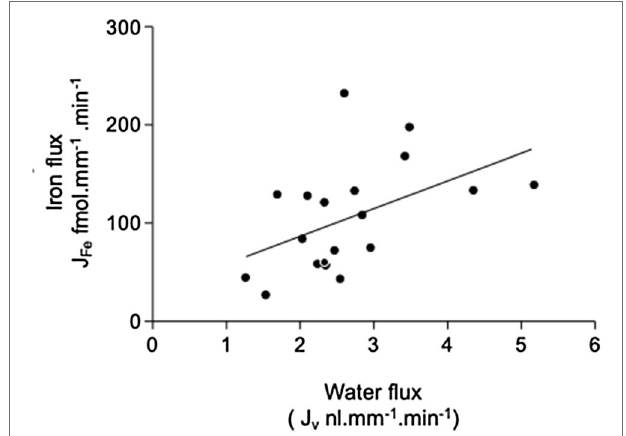
FIGURE 2 | Relationship between iron and fluid reabsorption in the perfused PCT (control data only). Iron flux J Fe plotted against water flux J v . Data are plotted for individual tubular fluid collections from 5 animals, n = 19 collections. Equation of regression line y = 28.26 + 29.93x; n = 19; r 2 = 0.23. The correlation coefficient r 2 = 0.23 was significant at the 5% level, indicating that there was a small significant positive correlation between the reabsorption of iron and water